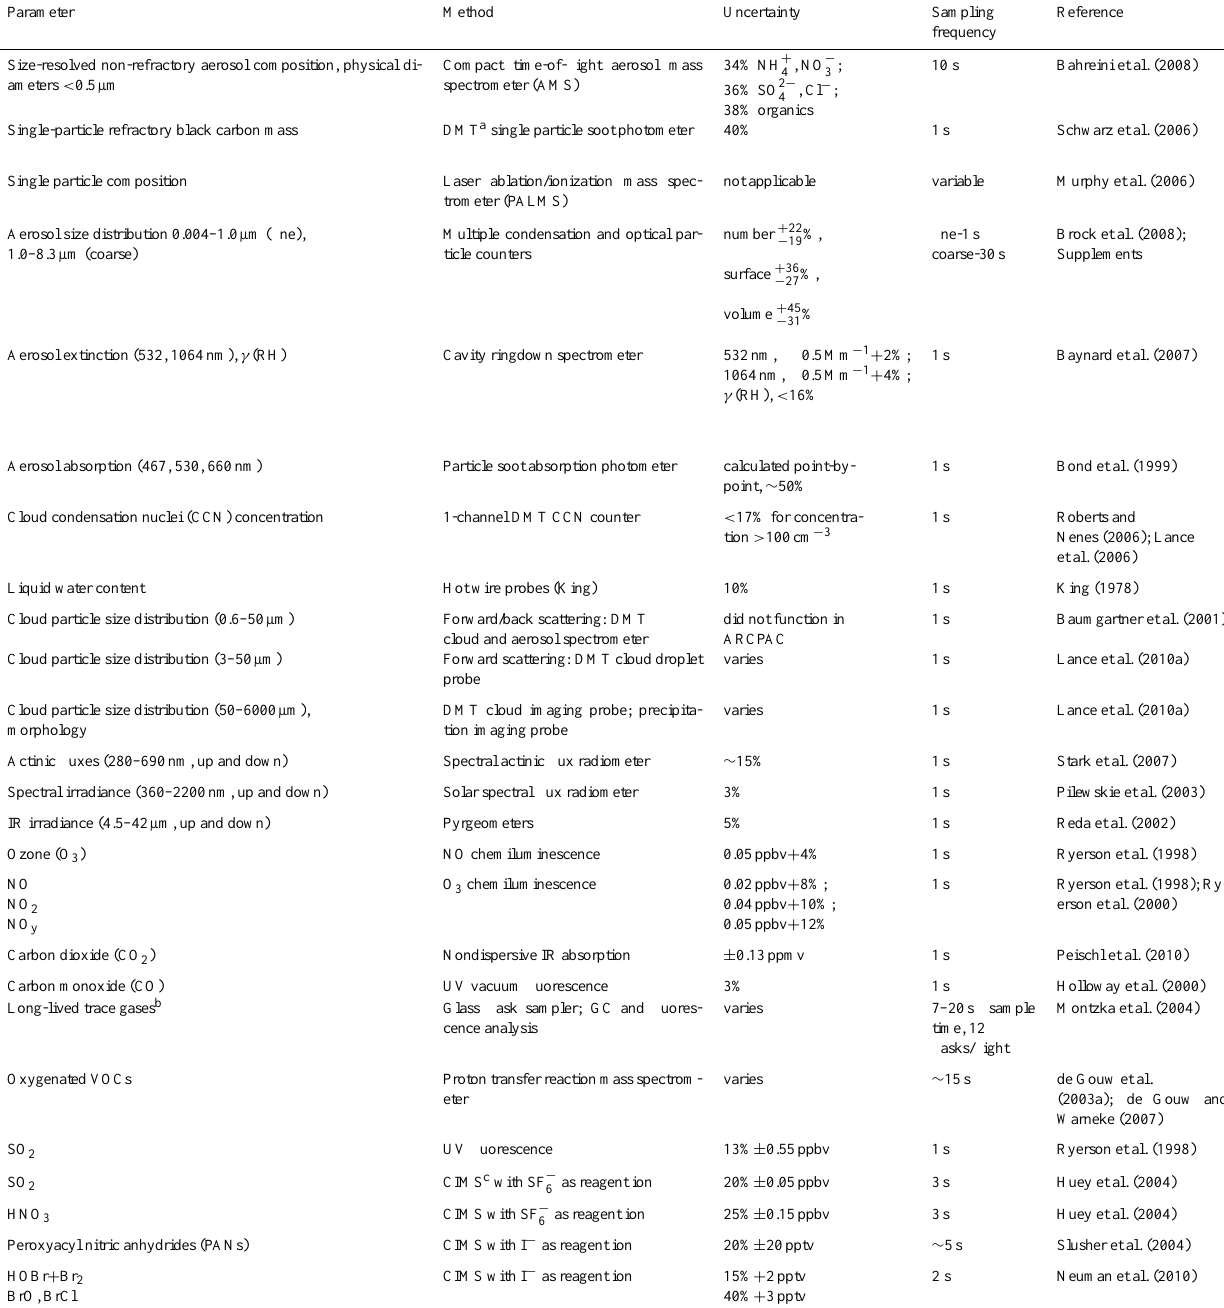
Table 1. Instruments, uncertainties,